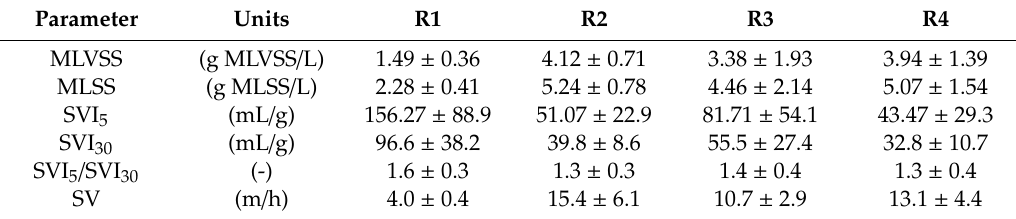
Table 1. Sedimentation properties and biomass concentration in